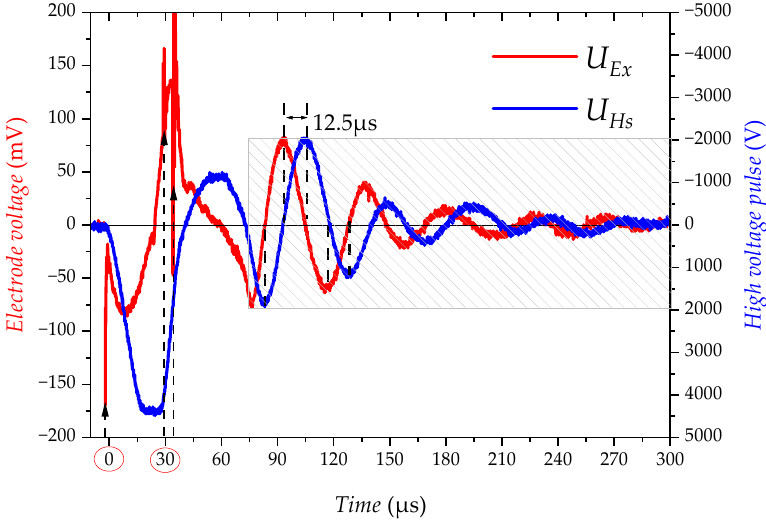
Figure 5. Time domain diagram of U Ex and U Hs (experiment).